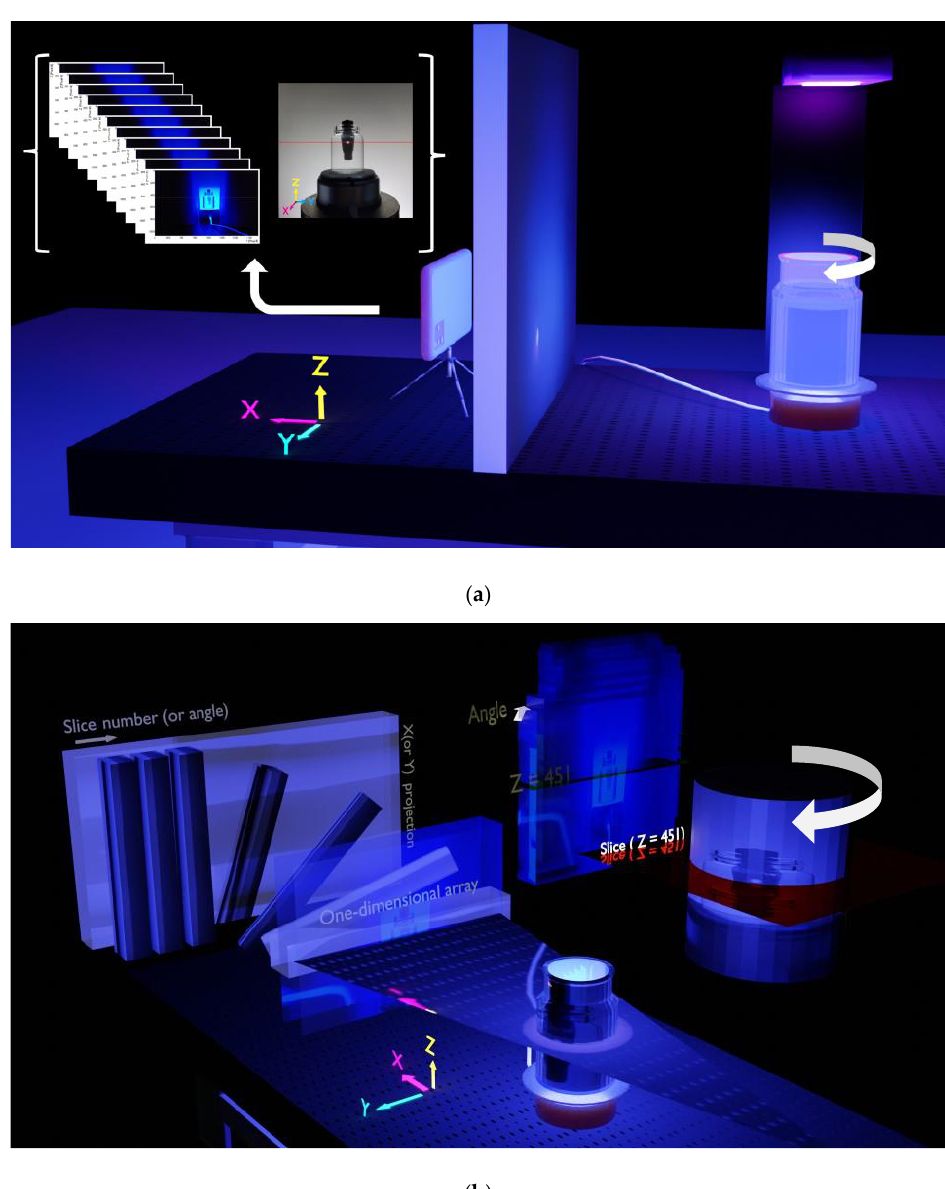
Figure 6. ( a ) A schematic of the sinogram with the combination of AbLS sample and the cell phone camera. A UV lamp was positioned approximately 10 cm above the AbLS sample with a T-shaped bar. The emission wavelength of the UV lamp was 365 nm. A 3 cm diameter 100 mL vial containing AbLS had a T-shaped bar with a microscopic hole in the center of the bar. The holes in the T-shaped bar immersed in the AbLS container can be seen. The AbLS sample vial was placed on an electric rotating disk. Then, the disk rotated at a constant speed. The rotated images were taken and extracted. The baseline for reconstructing the sinogram is indicated by the red solid line. The tomographic image was extracted and reconstructed based on this red line. This line corresponded to z = 451 pixel line value. ( b ) The specific z line in the photo corresponds to line data (or one-dimensional array) obtained from fixed angle. Then, by stacking these pixel line data from all angles, sinogram was formed. The sinogram was reconstructed from z = 451 pixel lines of each image.